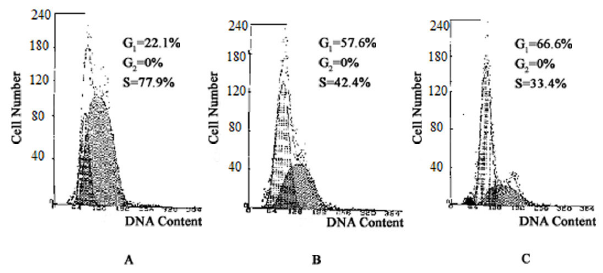
Figure 6. Effect of ChoPlas on the cell cycle of cultured CBRH-7919